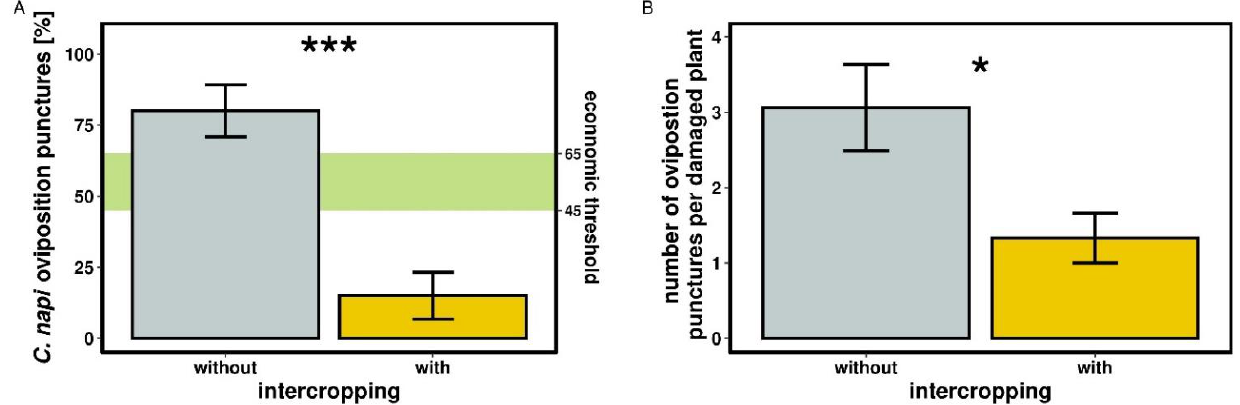
Figure 2. Intercropping Brassica napus improves management of Ceutorhynchus napi when Vicia faba did not freeze over winter. ( A ) Percentage of plants with oviposition punctures on control (gray) and intercropped (yellow) B. napus . ( B ) Average number of punctures on control (gray) and intercropped (yellow) damaged B. napus resulting from C. napi oviposition. Bars represent SEM; *** and * indicate p -values < 0.001 and < 0.05, respectively.